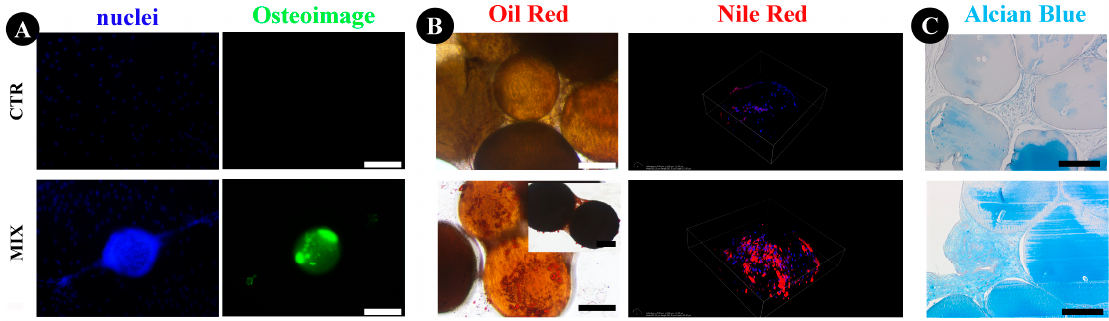
Figure 9. Evaluations of osteogenic, adipogenic, and chondrogenic potential of hASC, cultured on FAMs. Hoechst (nuclei) and Osteoimage stainings for osteogenesis ( A ), Oil Red and Nile Red staining for adipogenesis ( B ), and Alcian Blue staining for chondrogenesis ( C ). Scale bar = 200 μ m.